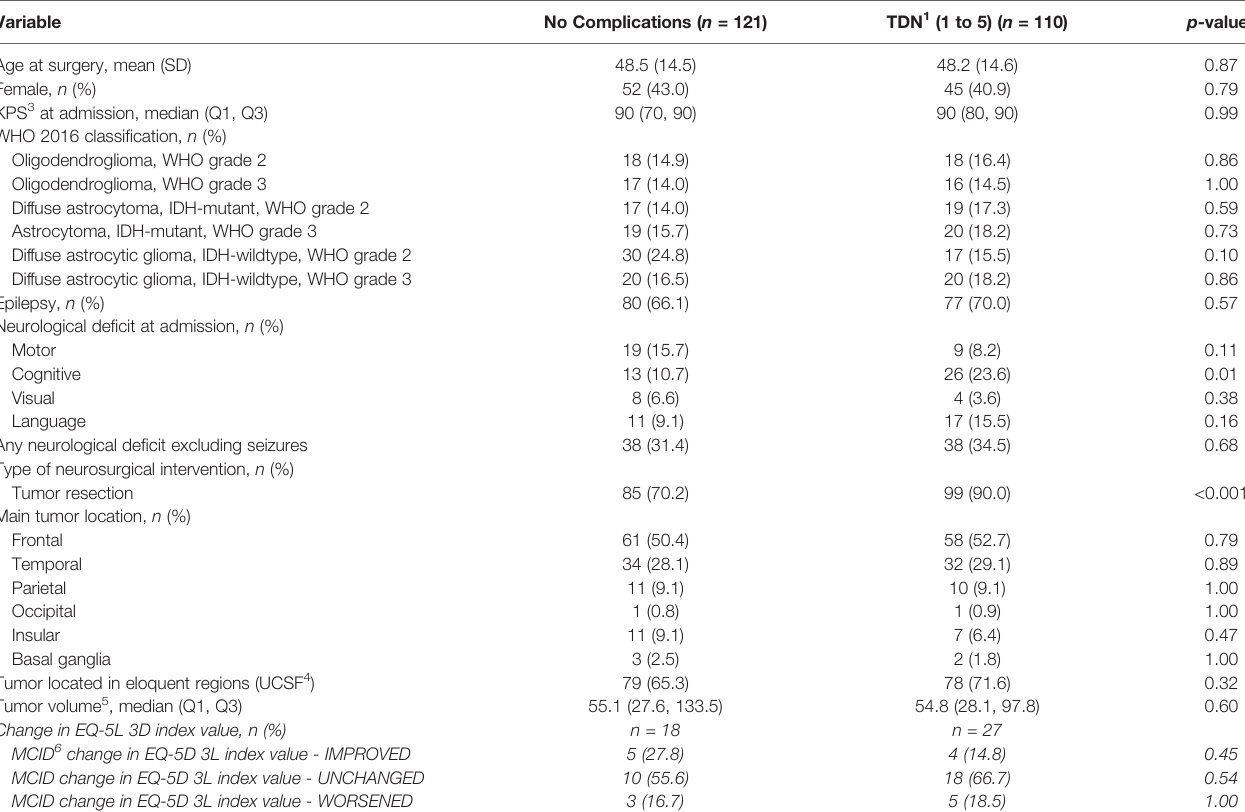
TABLE 3 | Patient characteristics and clinical variables in patients with and patients without complications related to surgery ( N = 231). Variable No Complications ( n = 121) Age at surgery, mean (SD)